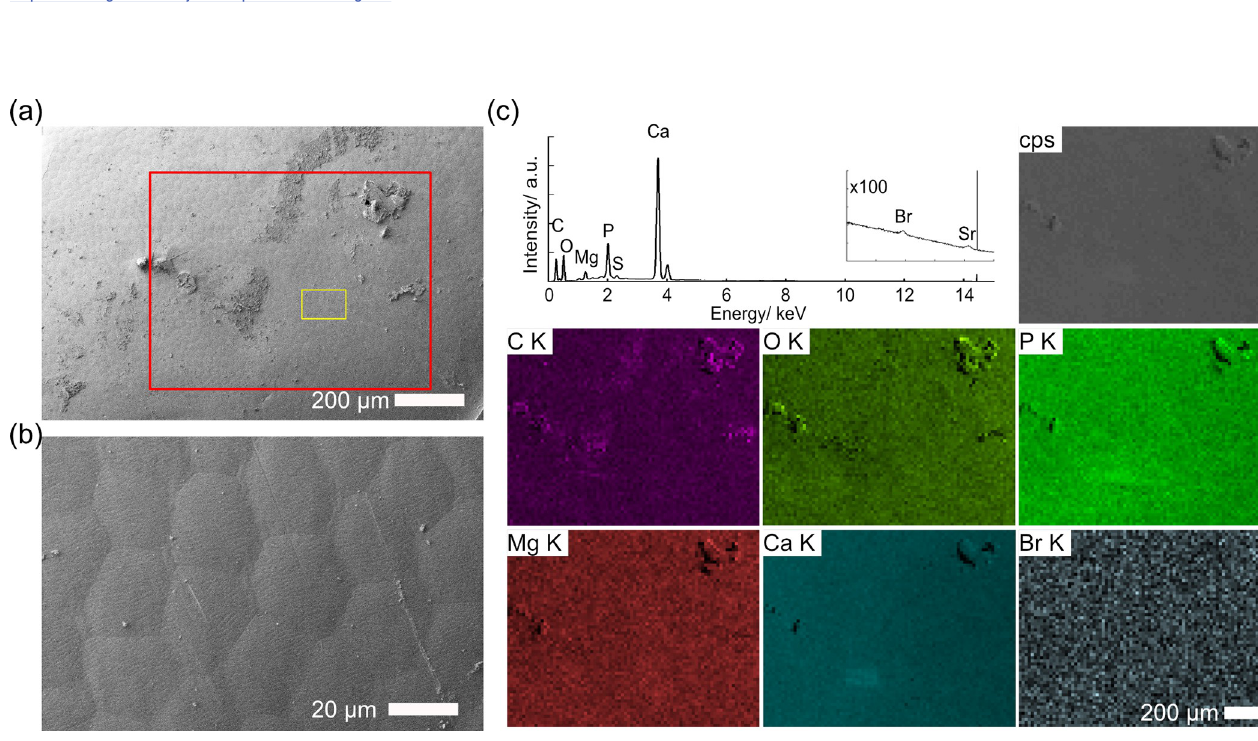
PLOS ONE | https://doi.org/10.1371/journal.pone.0272032 August 4,